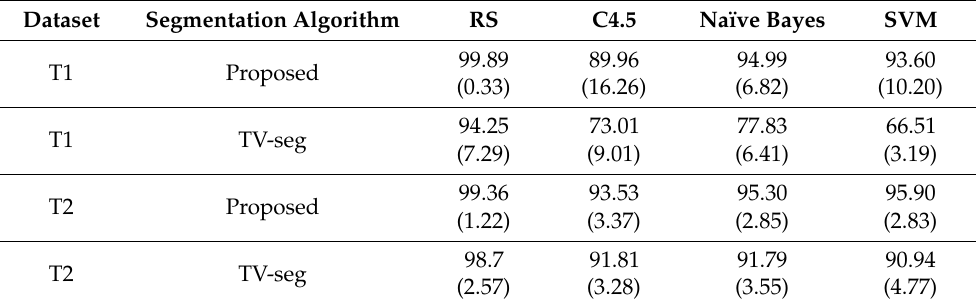
Table 2. The results of different classifiers and segmentation algorithms for DWPT.